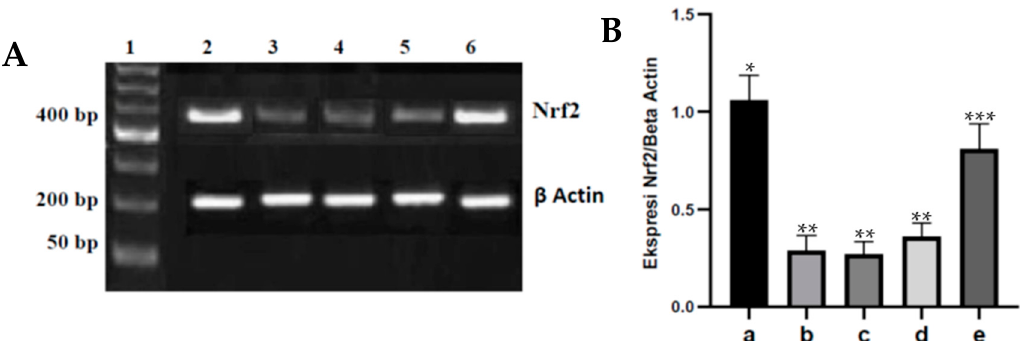
Figure 3. ( A ). Fucoidan nanoparticles’ effect on Nrf2 expression in aortic tissue of various treat- ments. A . Nrf2 expression in aortic tissue: marker (1); control rats (2); diabetic rats (3); fucoidan nanoparticles at doses of 75 (4), 150 (5), and 300 mg/kg BW (6). B . Fucoidan nanoparticles’ effect on Nrf2/ β actin in aortic tissue: control rats ( a ); diabetic rats ( b ), Fucoidan nanoparticles at doses of 75 ( c ), 150 ( d ), and 300 mg/kg BW ( e ). * - *** Columns with different letters statistically differ at p < 0.05.